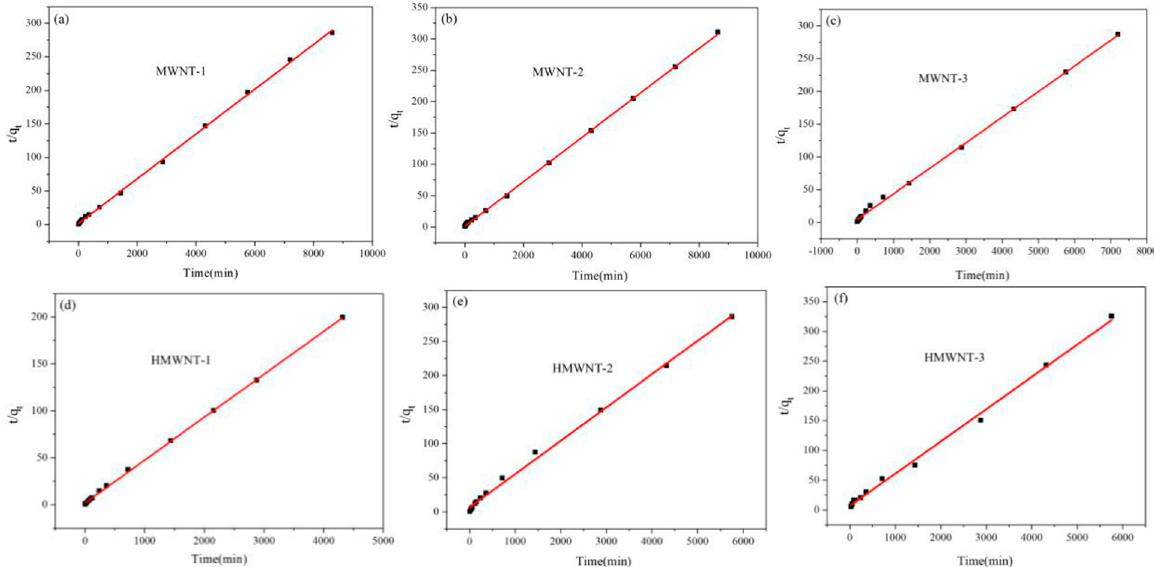
Figure 7. Pseudo-second-order kinetic curves of the adsorption of HA on the surface of MWNTs ( a – c ) and HMWNTs ( d – f ).